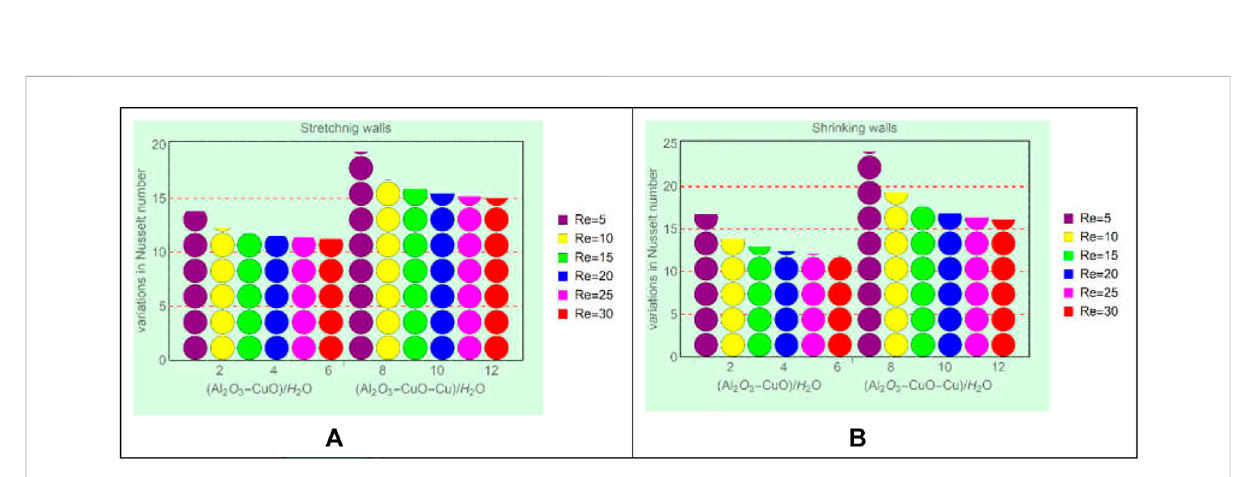
FIGURE 9 Local energy storage against (A) stretching and Re and (B) shrinking and